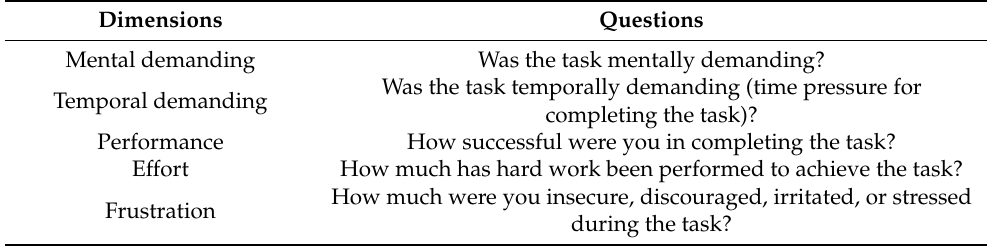
Table 1. Questions that were asked to measure cognitive load using